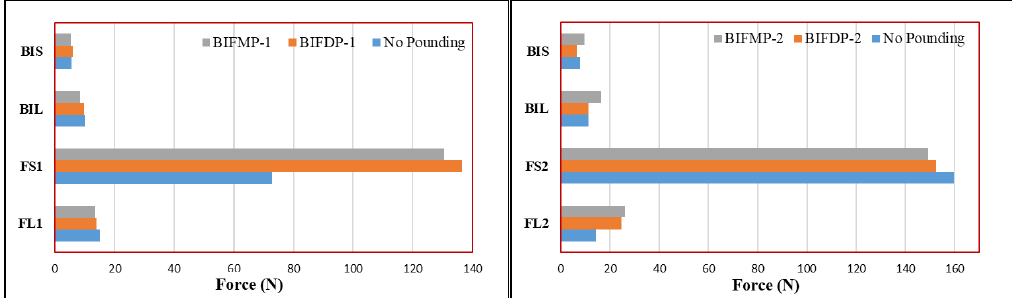
Figure 10. Maximum horizontal forces in flexible base-isolated models.